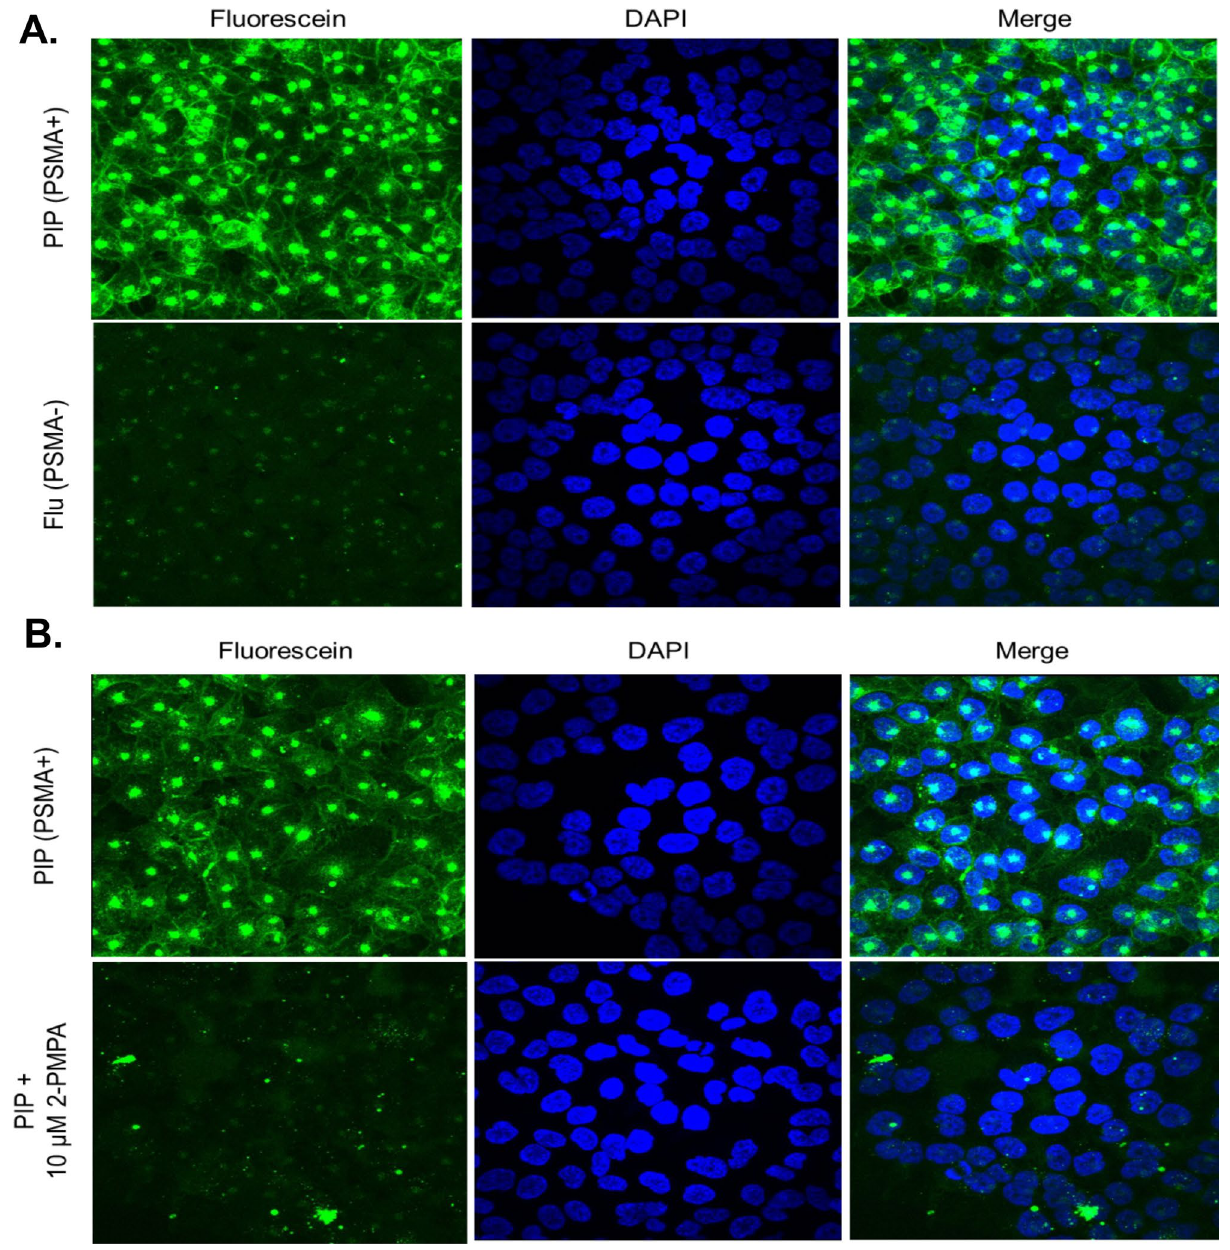
Figure 5. PE35-MU2 is selectively internalized by PSMA expressing cells. ( A ) Confocal microscopy images of PIP-PC3 or Flu-PC3 treated with Flor-PE35-MU2 for 1 h. ( B ) PIP-PC3 cells treated with Flor-PE35-MU2 plus or minus 10 μM